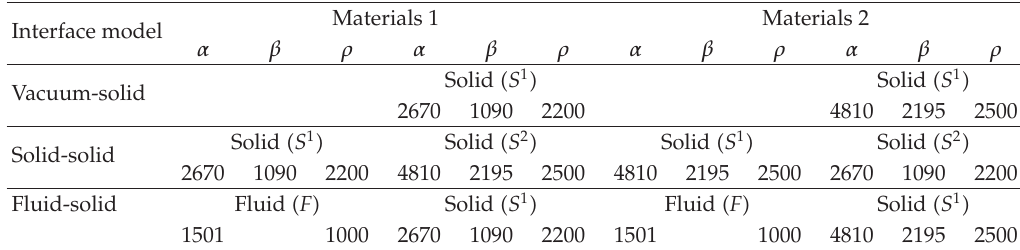
Table 1: Material properties used for numerical